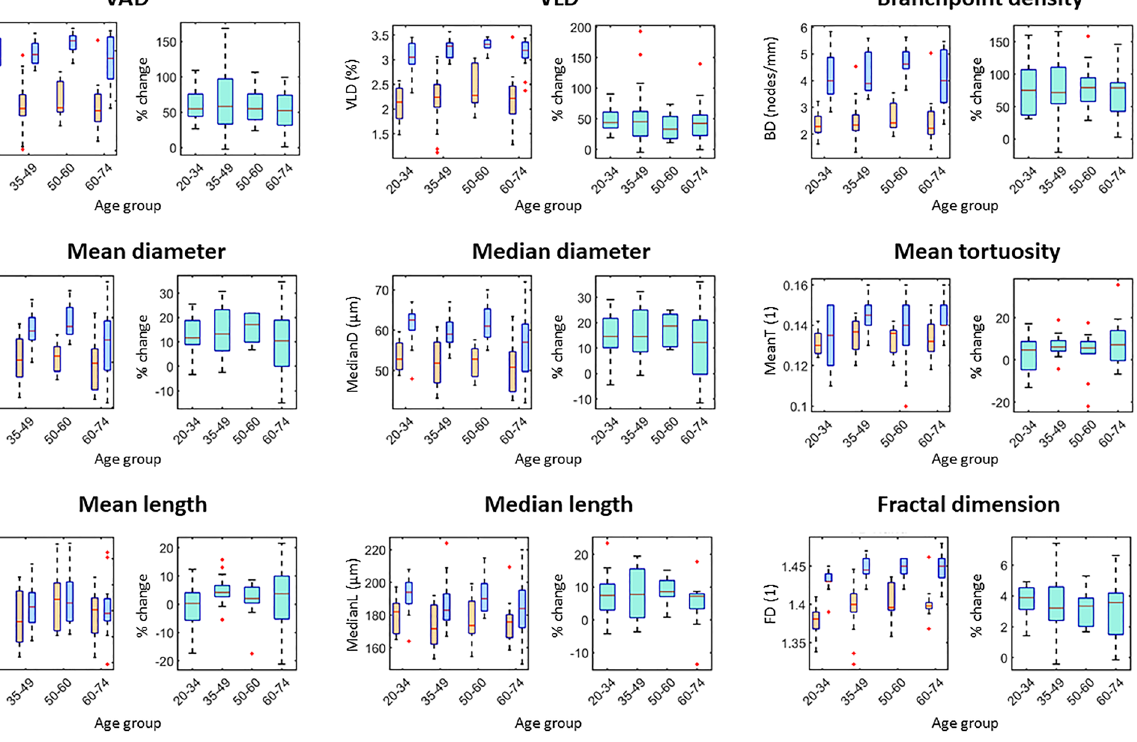
Figure 2. Box plots of age-dependent healthy reference values for selected metrics in the hand. For each metric, the left plot shows the values at baseline (orange) and PORH (blue) and the right plot shows the % change (turquoise). Red lines indicate the median value, boxes indicate the 25th and 75th percentiles, and the black dotted lines indicate the range. Outliers are indicated by red crosses. A unit of 1 indicates a dimensionless metric. VAD vessel area density, VLD vessel length